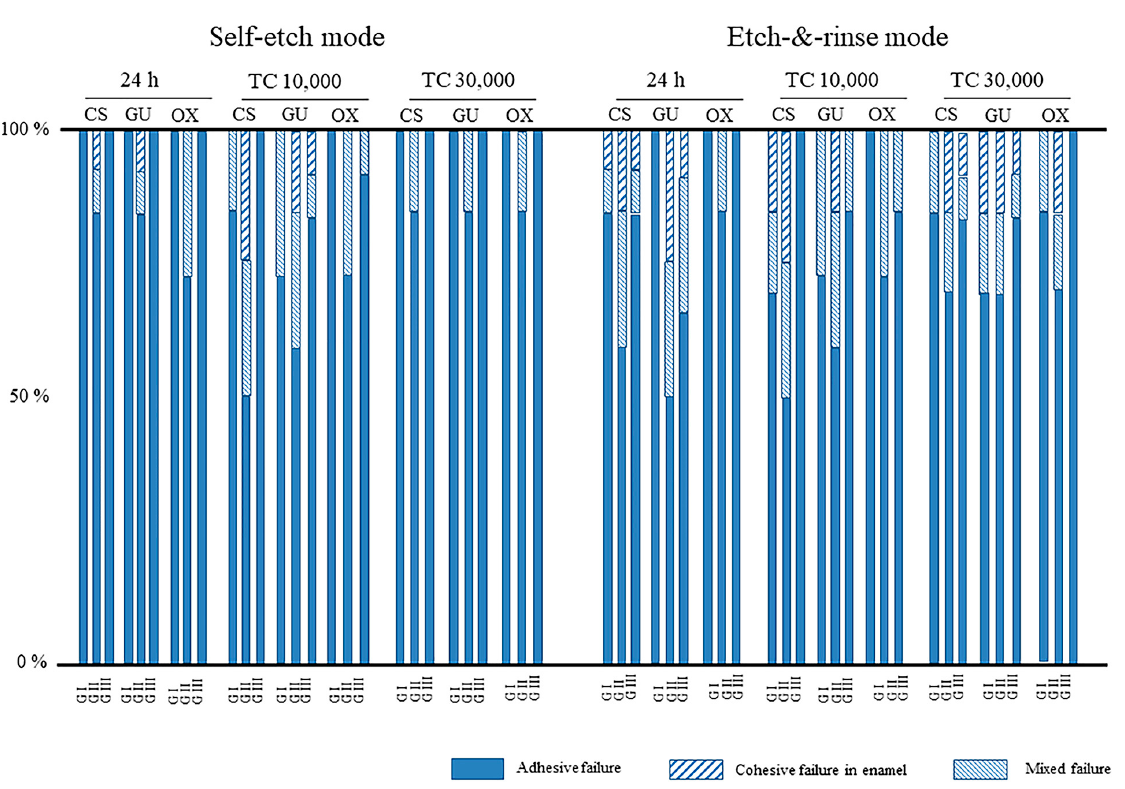
Figure 4. Failure mode analysis of the debonded enamel specimens. CS: Clearfil SE Bond 2, GU: G2-Bond Universal, OX: OptiBond eXTRa, TC: thermal cycle, G I/II/III: Group I/II/III. Table 5. Thickness of adhesive layer in different application methods in different adhesive systems.